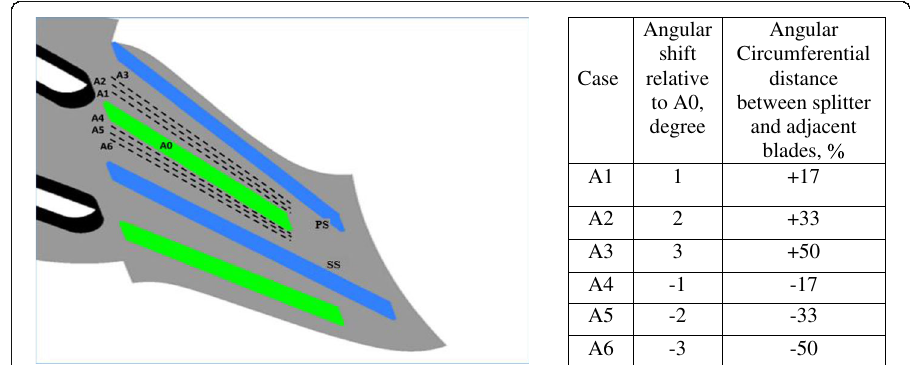
Fig. 8 Geometric configuration for splitter vanes and relative locations of investigated